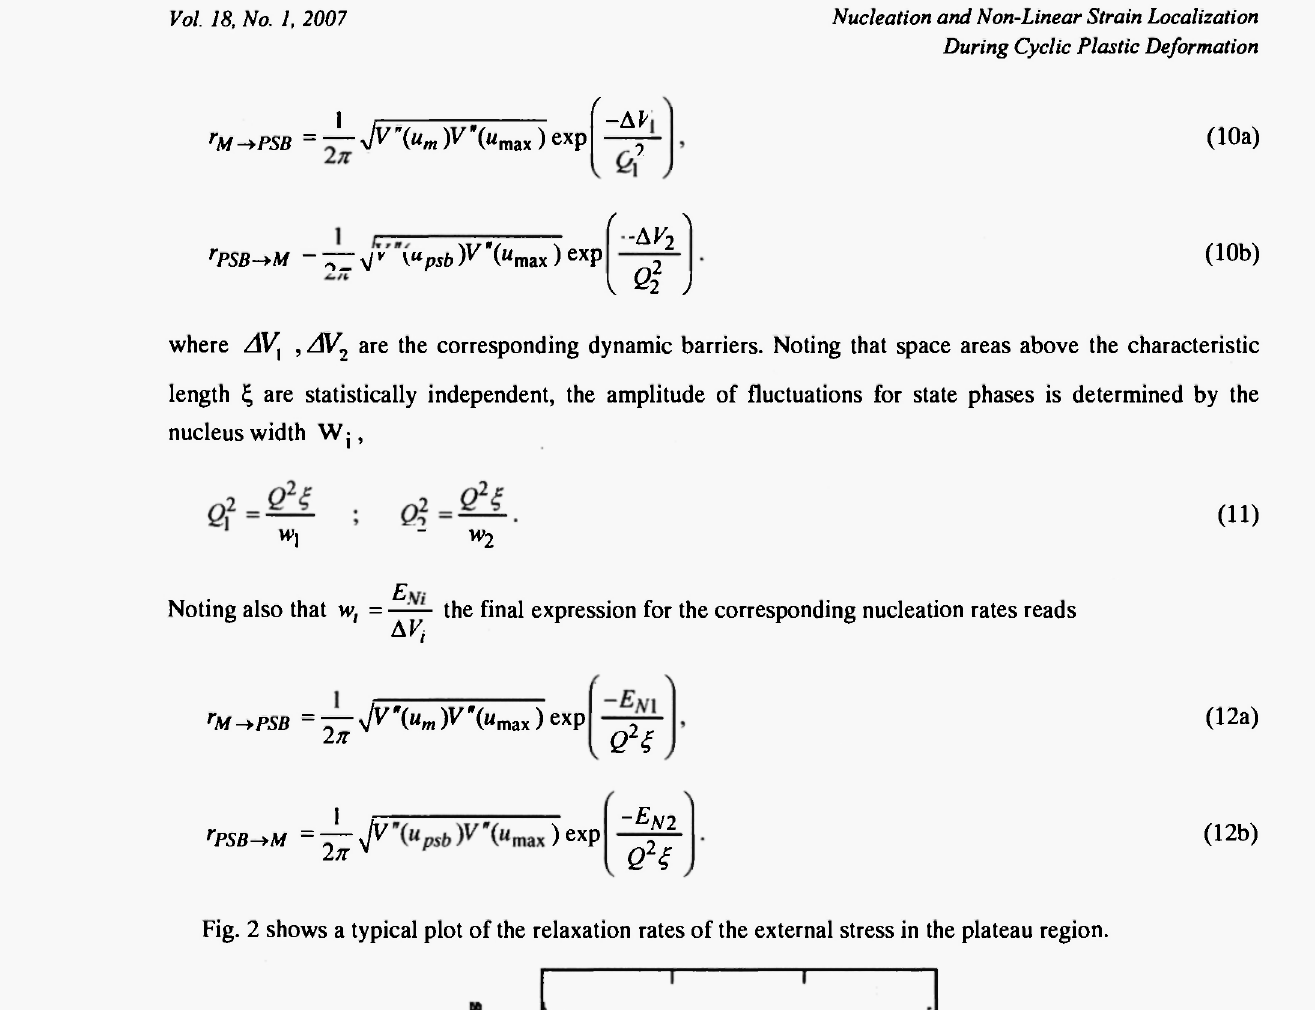
Fig. 2: Nucleation rates as a function of external